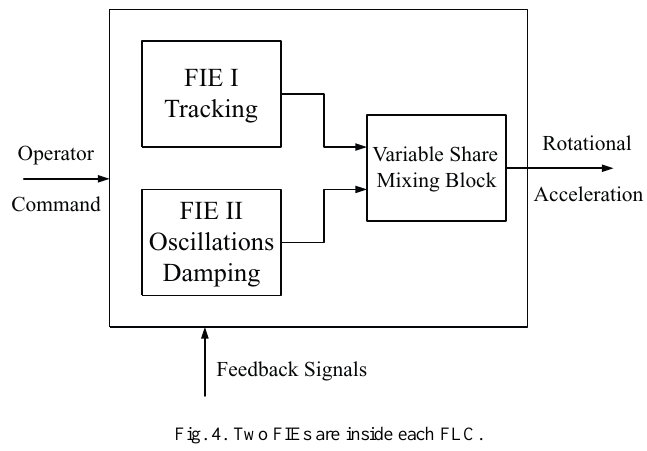
Fig. 4. Two FIEs are inside each FLC.